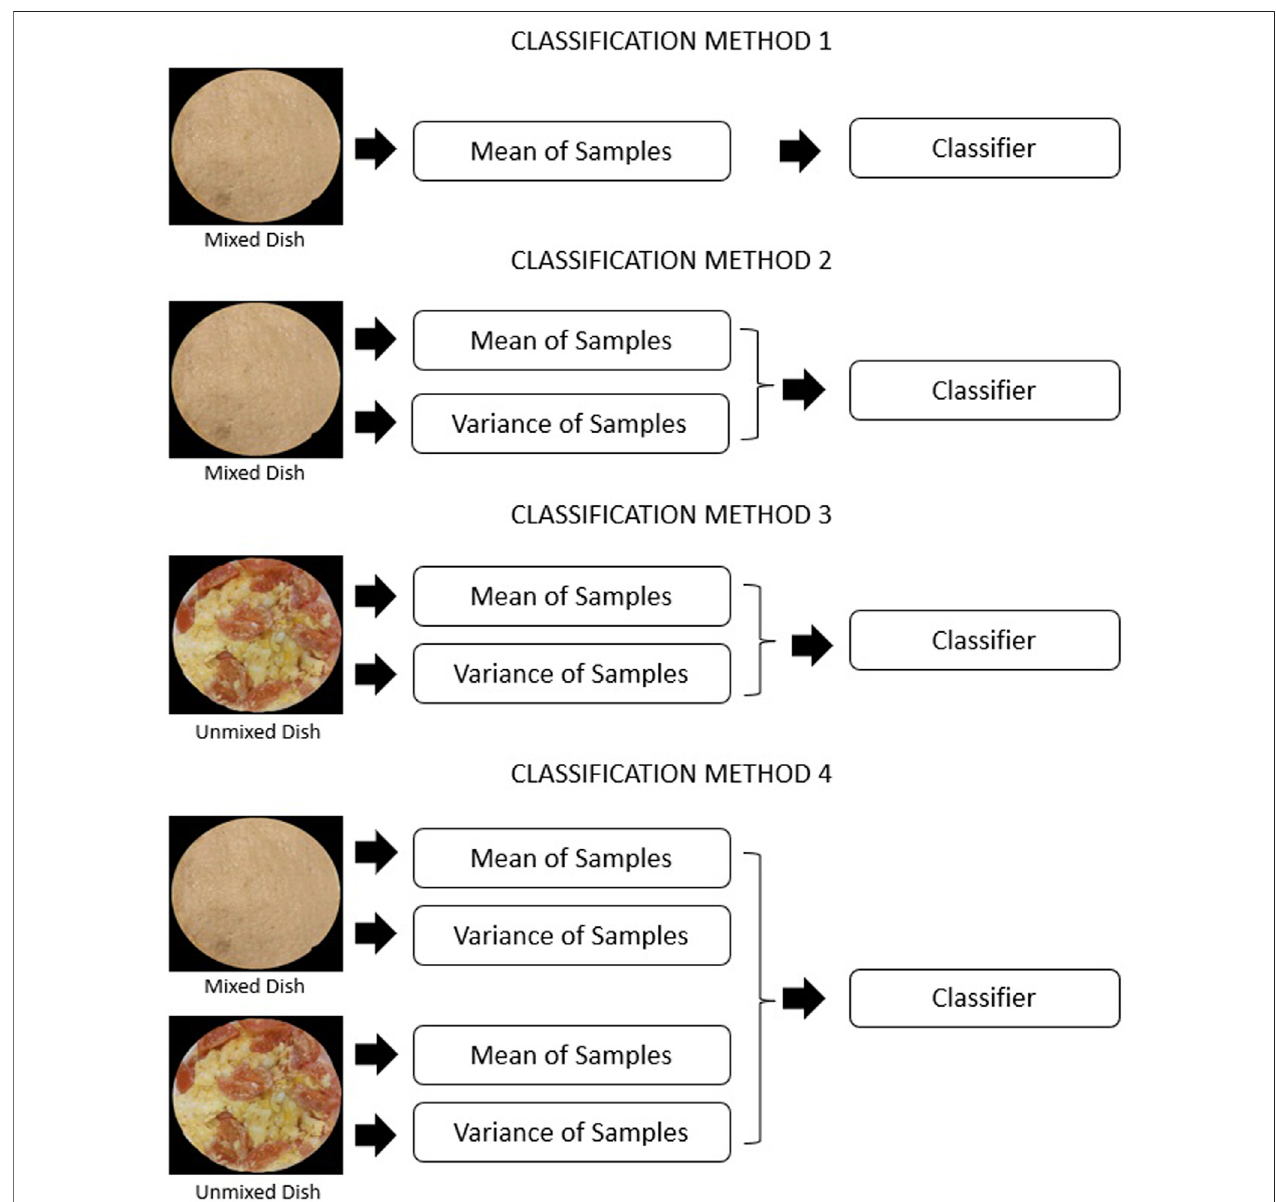
FIGURE 5 | Schematics showing classi fi cation methods tested. Each dish was tasted twice – before and after chewing, with taste metrics extracted for at each stage.